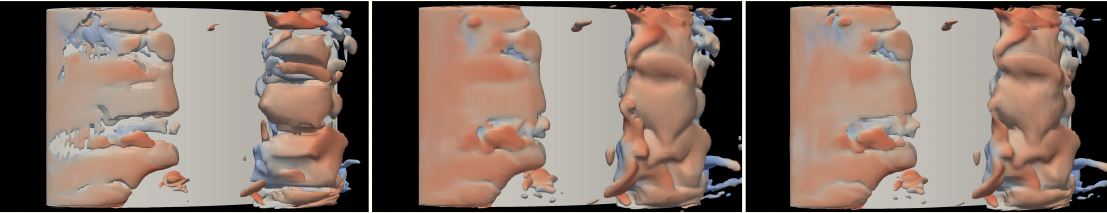
Figure 7. Comparison of patterns of cavitation structures in regime I for coarse ( left ), dynamic refinement ( middle ), and static refinement ( right ) meshes: isosurface (cid:101) α = 0.5 colored with streamwise velocity u x from LES using Schnerr–Sauer